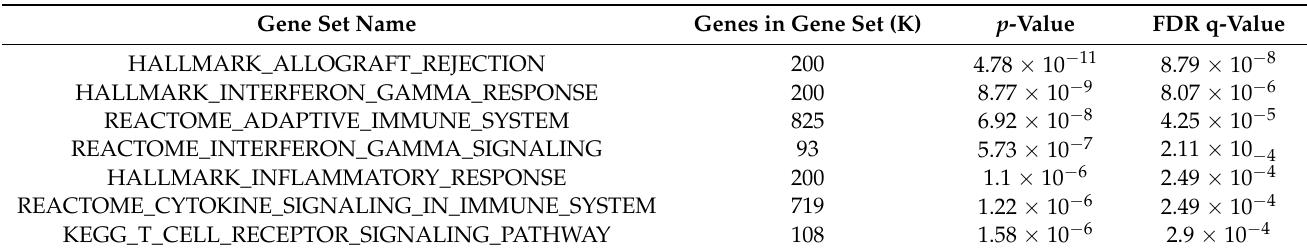
Table 3. Gene set enrichment analysis of gene sets significantly enriched in African-American obese patients compared to European obese patients under gene expression number GSE79858.